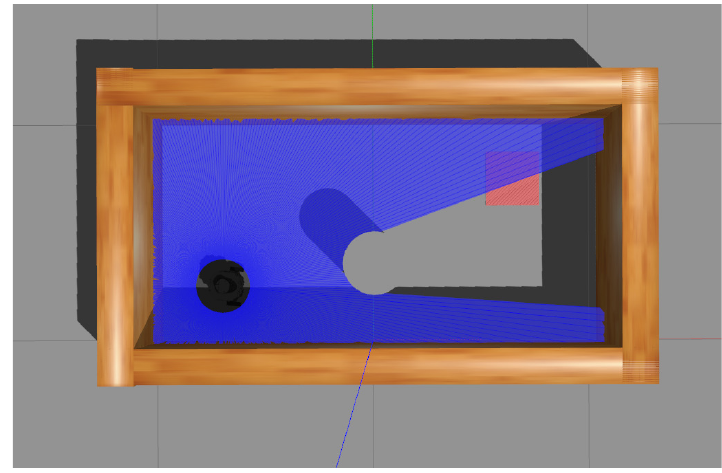
Figure 4. The second experimental scenario with smaller size and one obstacle. Table 1. The comparison between the two scenarios.